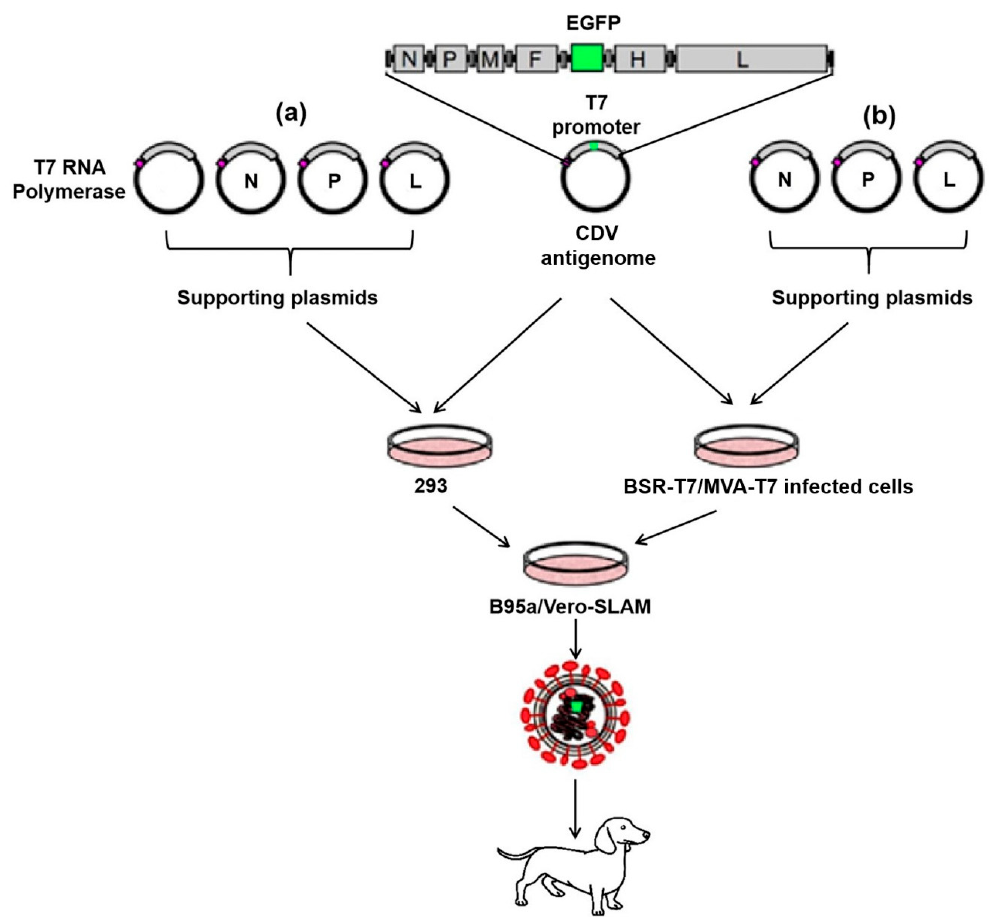
Figure 1. Reverse genetic system for the recovery of a recombinant canine distemper virus (CDV) wild-type strain. The five recombinant plasmids used for the recovery of a recombinant CDV strain, including one T7-promoter driven full-length cDNA expressing plasmid containing the enhanced green fluorescence protein (EGFP) gene inserted between the fusion (F) and hemagglutinin (H) genes, four cytomegalovirus (CMV) promoter-governed supporting plasmids expressing the nucleocapsid (N), phospo (P), and large (L) proteins respectively, and the T7 polymerase plasmid ( a ), which could be replaced by baby hamster kidney cells stably expressing T7 RNA polymerase (BSR-T7) or the modified vaccinia Ankara (MVA-T7) virus ( b ). The recovery process for the generation of the recombinant CDV is as follows: All plasmids are used for the simultaneous cotransfection of 293 cells ( a ), or BSR-T7 cells or MVA-T7 infected cells ( b ), followed by identification of the expression of EGFP in infected foci, and the overlay of B95a or Vero-SLAM (Vero cells expressing the signaling lymphocytic activation molecule [SLAM] receptor) cells for subsequent viral propagation.